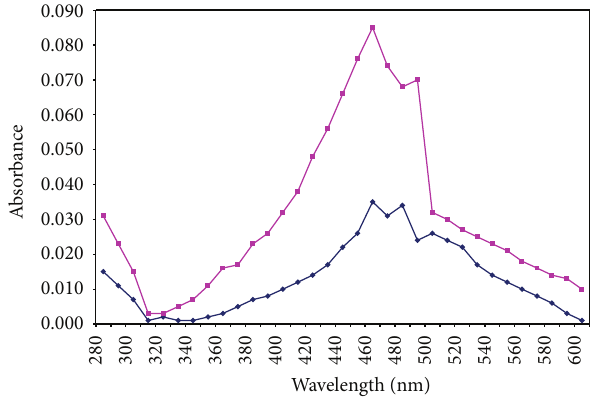
Figure 2: Calibration graph for determination of amitriptyline, 1.0 to 10.0 𝜇 g mL −1 .